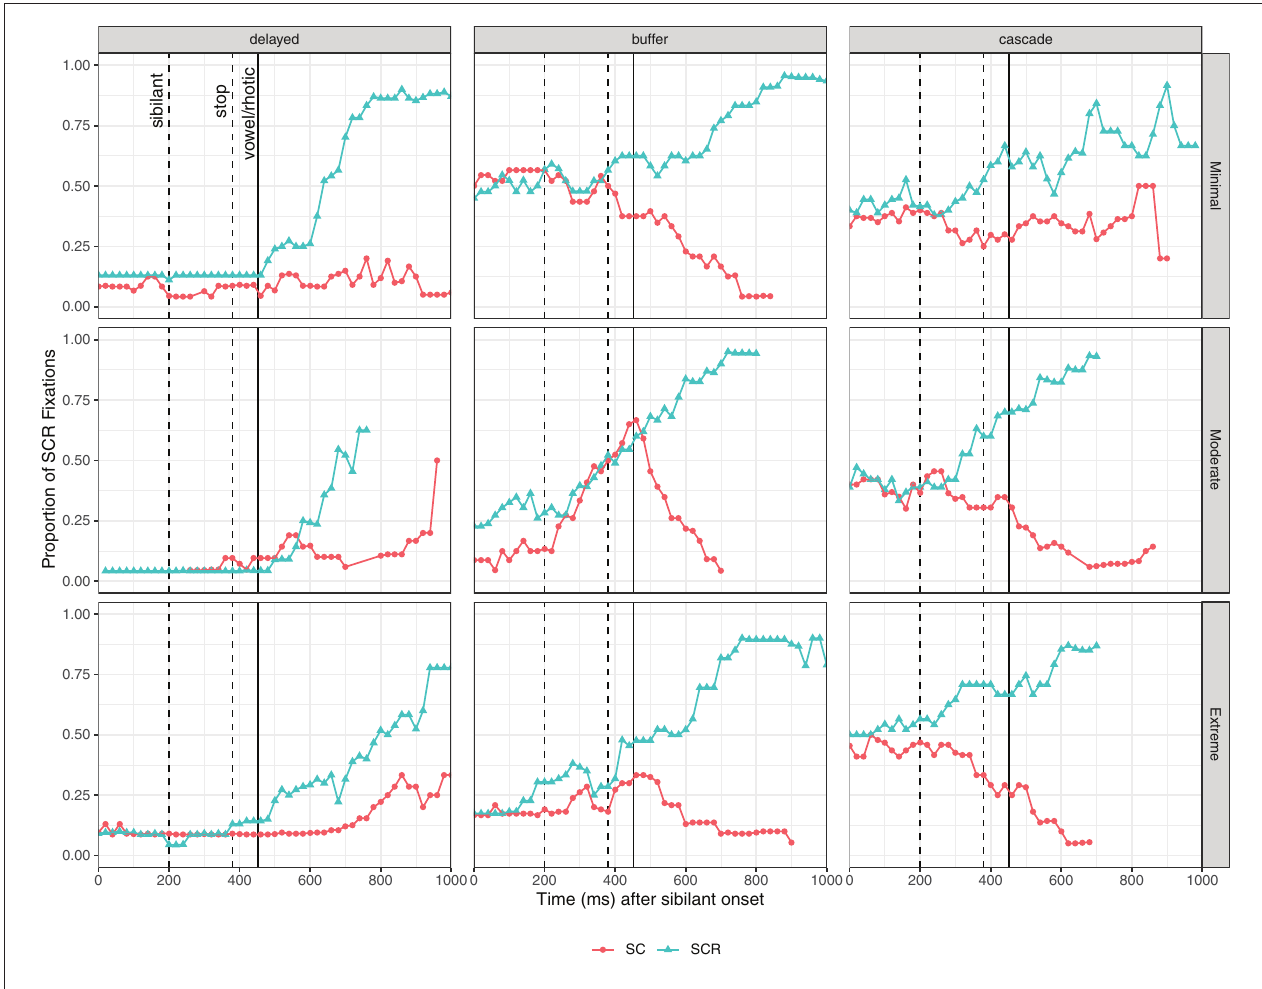
FIGURE 5 | Individual fixation proportion for /sCr/ clusters (y-axis) by time following the sibilant onset (x-axis, binned into 20 ms windows), cluster type (color: /sC/ = red circles, /sCr/ = teal triangles), retraction condition (rows), and pattern exhibited (columns). The vertical lines represent a 200 ms delay from the onset of the sibilant, stop, and vowel/rhotic. A fixation executed during the sibilant interval would be observed between the black dashed vertical